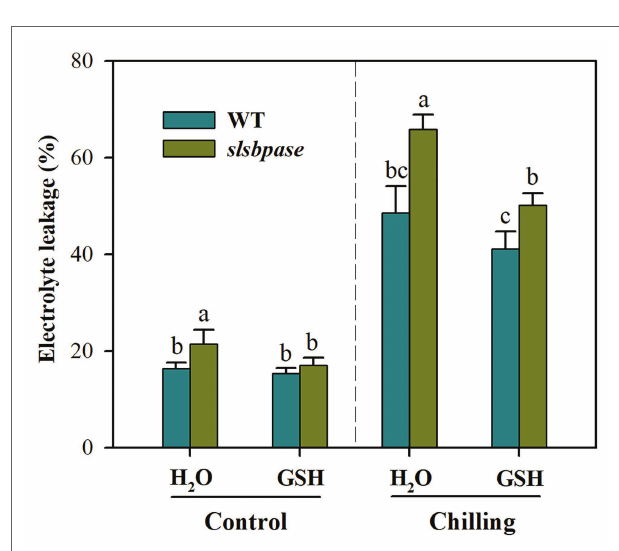
FIGURE 7 | Effects of exogenous GSH on chilling damage as represented by relative electrolyte leakage. At the fourth-leaf stage, slsbpase mutants and wild- type plants were sprayed with or without GSH on 3 consecutive days and then subjected to a 24 h chilling stress. Following that, leaves from different groups were sampled for the determination of electrolyte leakage. The results are mean values ± SDs from three independent experiments, and different letters on top of each column represent significantly different values at p < 0.05 among treatments.